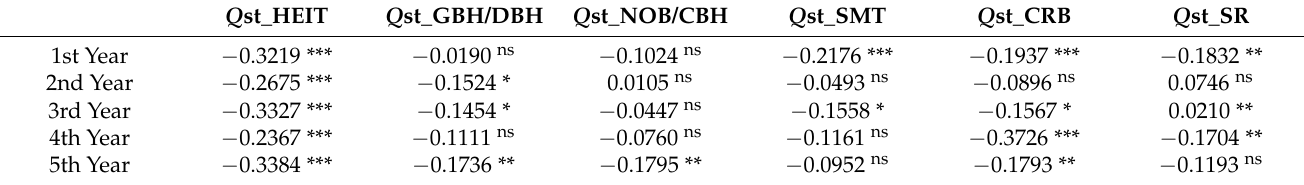
Table 4. Correlation between the Q ST matrices of the 30 measured traits and the geographic distance matrix by